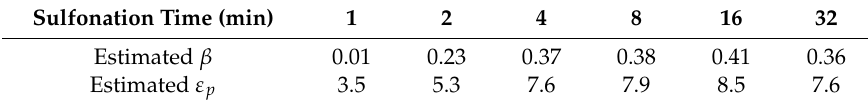
Table 2. Values of the estimated dielectric mismatch ( β ) and particle dielectric constant ( ε p ). Sulfonation Time